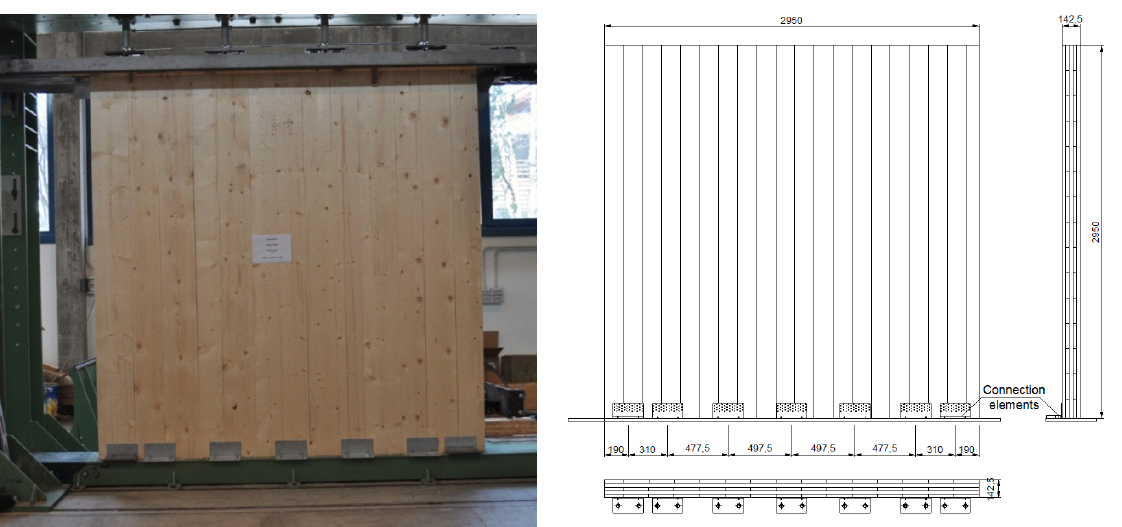
Figure 2. Wall B: Geometric